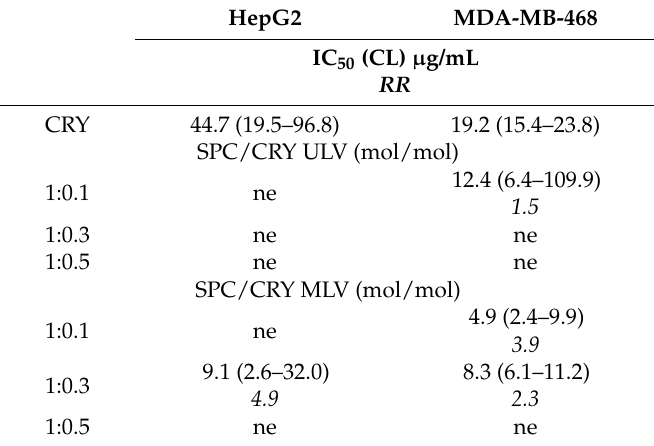
Table 3. IC 50 values of CRY administered as pure compound or as ULV and MLV formulations in HepG2 and MDA-MB-468 cells.